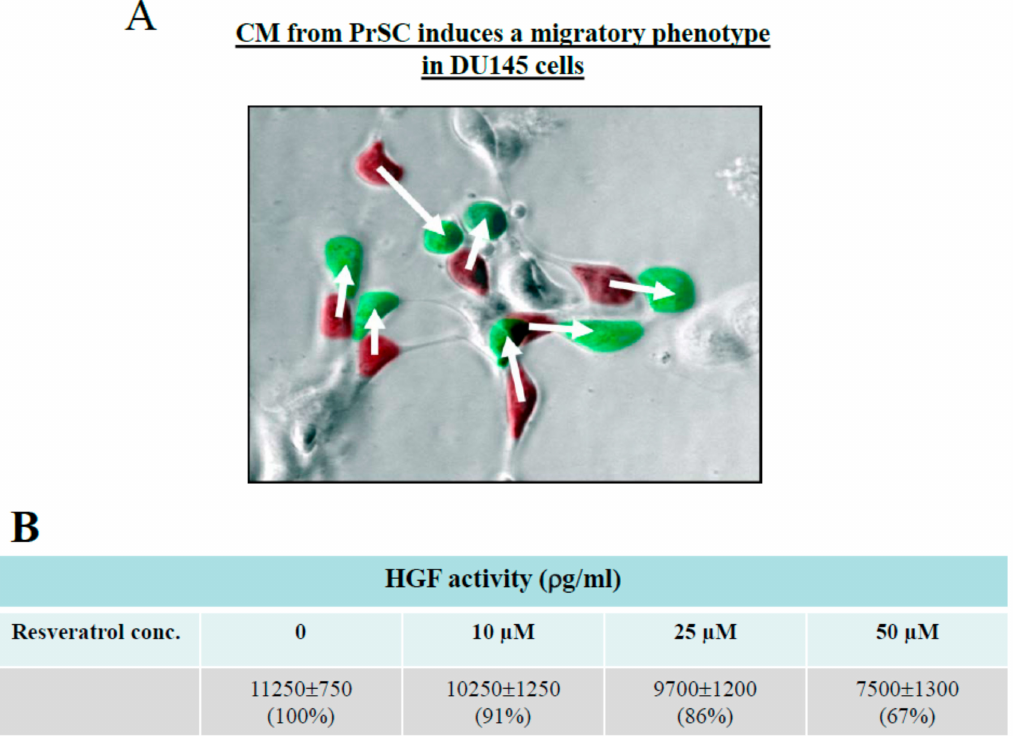
Figure 3. ( A ) Time lapse microscopy analysis of migration of prostate DU145 cells, in response to CM from PrSC. Two images, one taken at time 0 h and a second one take at time 2.4 h, were overlaid using Adobe Photoshop. Cells at 0 h were marked red, and cells at 2.4 h were marked green. The coordinates for each cell were obtained for each of the two time points, and the change in the distance for each cell was shown. ( B ) E ff ect of treatment by resveratrol for 24 h on secreted hepatocyte growth factor (HGF) by PrSC, assayed by